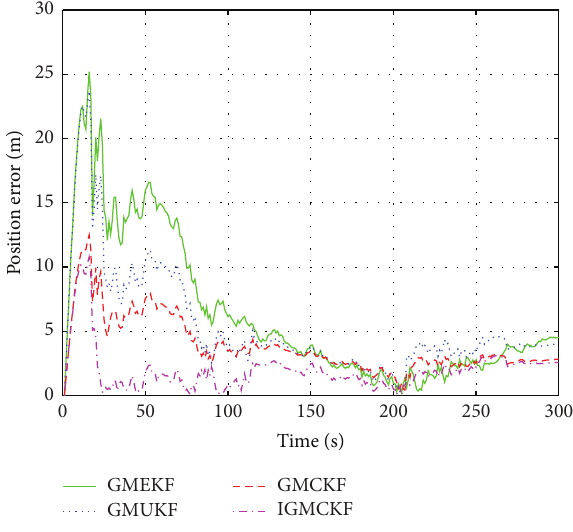
Figure 2: The curve of position error. Table 2: RMSE and time of different